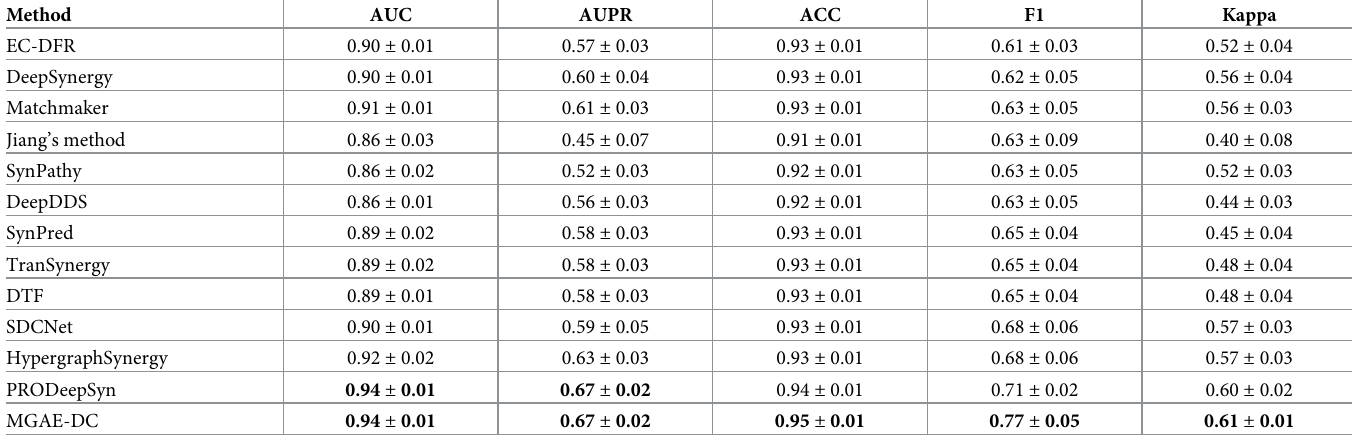
Table 2. The classification performances of different methods on drug-drug synergy prediction on the O’Neil dataset using Loewe score, in terms of mean and stan- dard